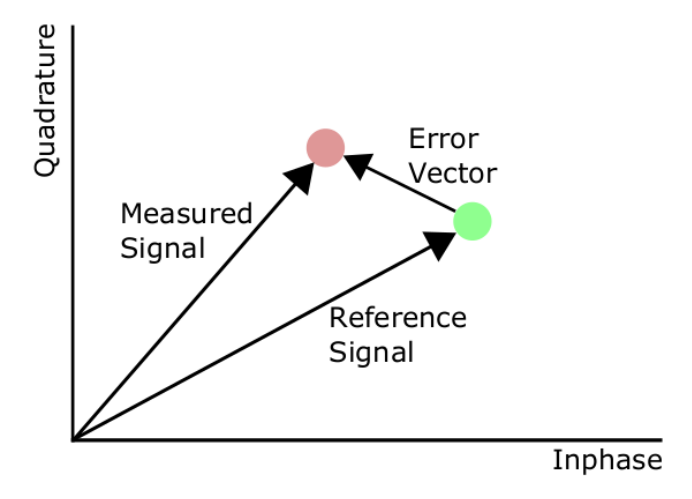
Figure 3. Illustration of error vector magnitude (EVM).